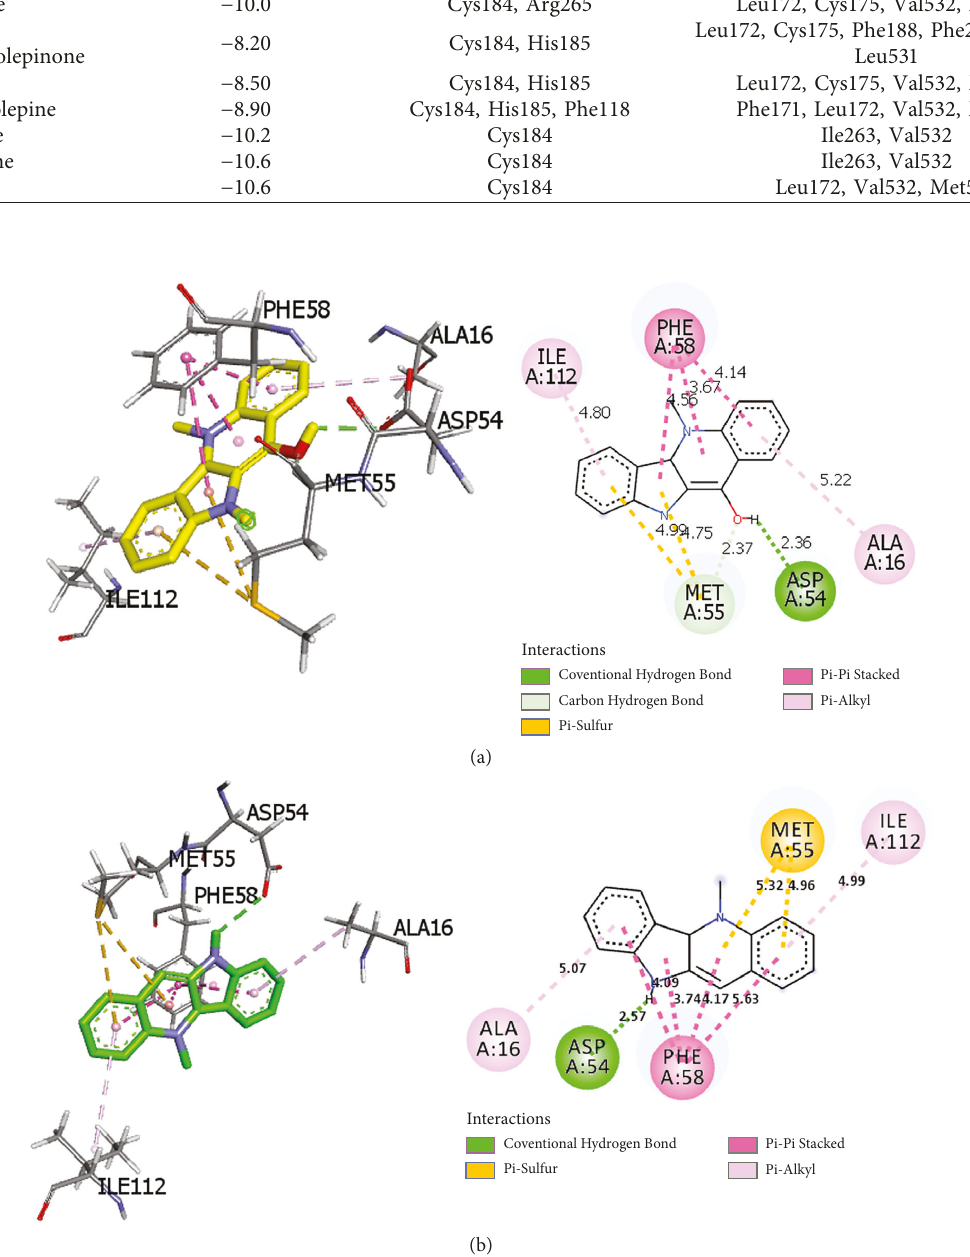
Figure 5: Interactions of some alkaloids with wt- Pf DHFR: 3D (left) and 2D (right) views of the interactions of (a) hydroxycryptolepine and (b) cryptolepine with residues in the binding region of wild-type Pf DHFR (3QGT). Description of interactions is provided under 2D